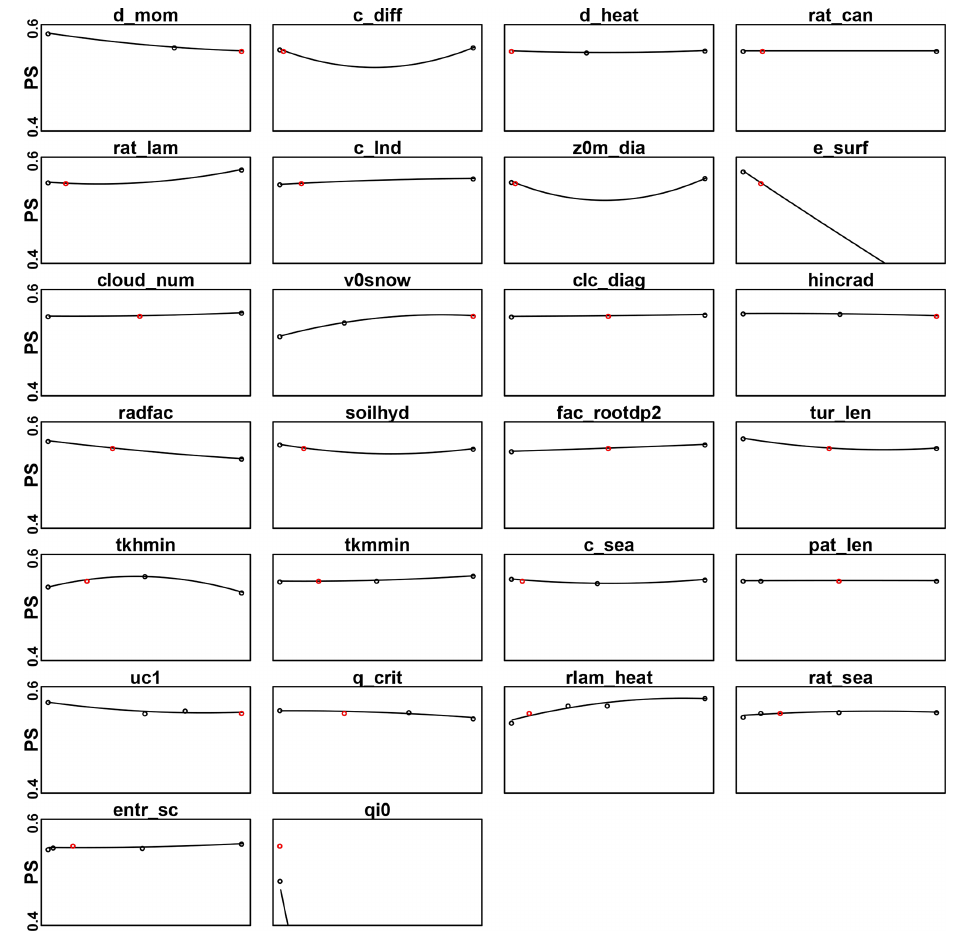
Figure 3. PS calculated for near-surface temperature (T2M), daily precipitation (PRE) and total cloud cover (CLCT) together, for all the different tested parameter values, over the entire Central Asia domain. The red marks represent the PS values obtained for the default